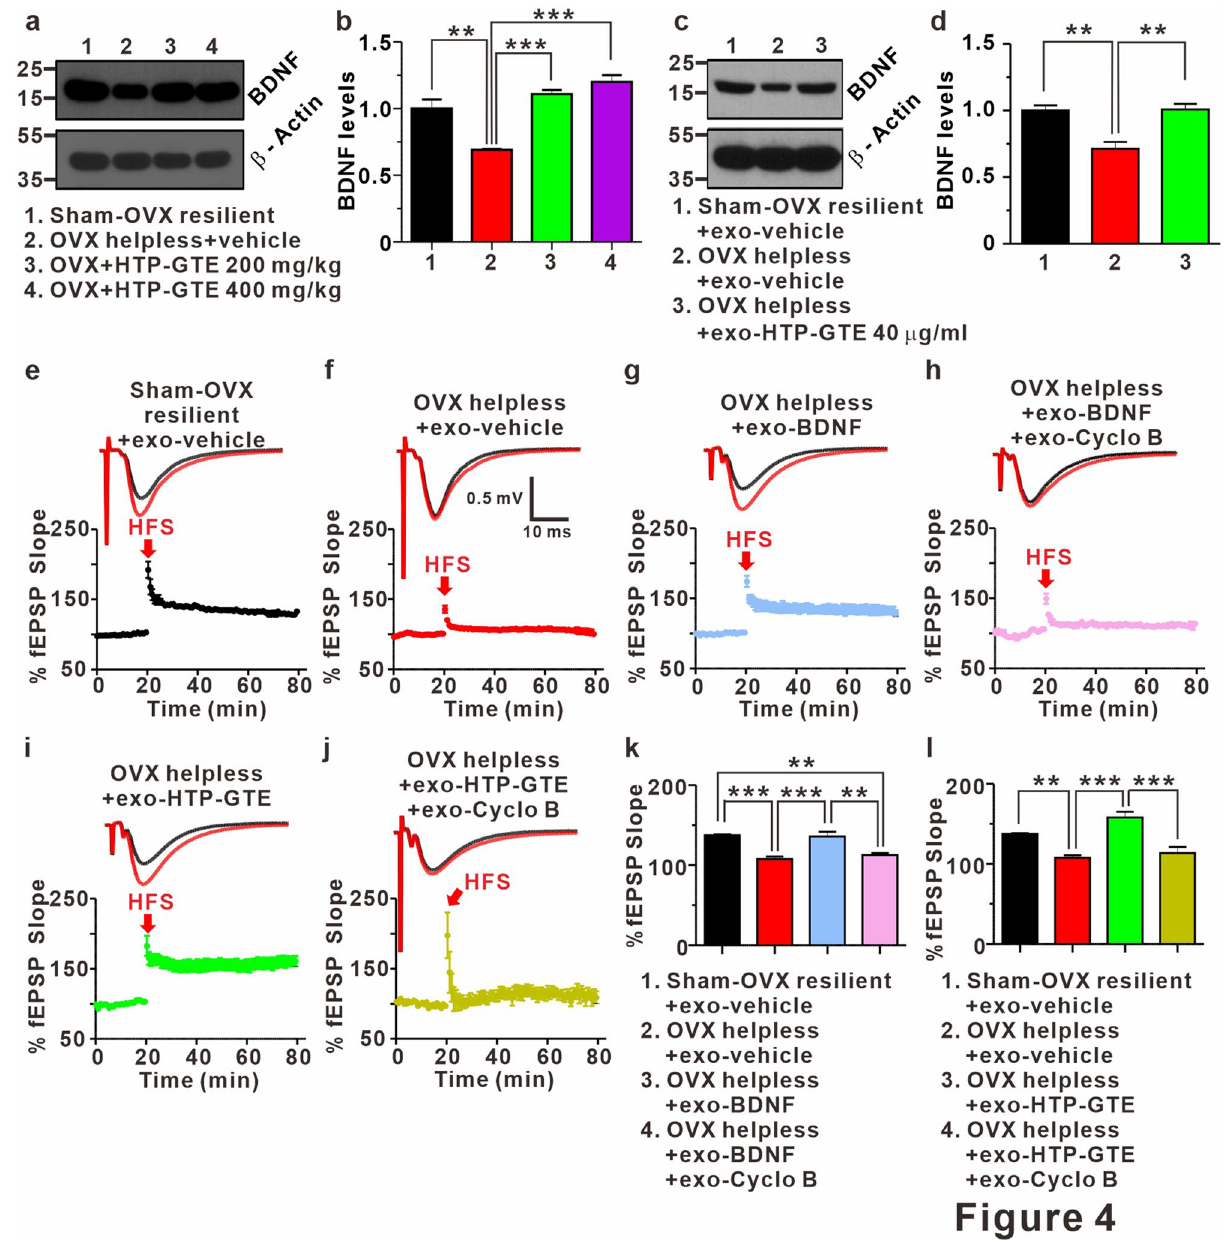
Figure 4. Regulation of BDNF-TrkB pathway underlies HTP-GTE-dependent amelioration of hippocampal synaptic impairments in helpless OVX rats. ( a, b ) Western blot of BDNF level in hippocampus on sham-OVX resilient + vehicle, OVX helpless + vehicle, OVX + HTP-GTE 200 mg/kg, and OVX + HTP-GTE 400 mg/kg groups in oral administration of HTP-GTE or vehicle solution daily for 4 weeks (Sham-OVX resilient + vehicle: 1.00 ± 0.07; OVX helpless + vehicle: 0.69 ± 0.01; OVX + HTP-GTE 200 mg/kg: 1.11 ± 0.03; OVX + HTP-GTE 400 mg/kg: 1.20 ± 0.05, n = 3 brains/group). Full-length blot is presented in Supplementary Fig. S13. ( c,d ) Western blot of BDNF level in hippocampus of exogenous application of HTP-GTE for 2 h (Sham-OVX resilient + exo-vehicle: 1.0 ± 0.04; OVX helpless + exo-vehicle: 0.71 ± 0.05; OVX helpless + exo-HTP-GTE 40 μg/ml: 1.01 ± 0.04, n = 3 brains/group). Full-length blot is presented in Supplementary Fig. S13. ( e–j ) Top: representative traces showing EPSPs before (average of 20 traces, black line) and after (average of 180 traces, red line) high-frequency stimulus. Bottom: average time courses for EPSP amplitudes during LTP induction in all groups. ( k,l ) Quantified graph was shown (Sham-OVX resilient + exo-vehicle: 137.4 ± 1.02, n = 5 slices/3 rats; OVX helpless + exo-vehicle: 107.6 ± 3.18, n = 8 slices/3 rats; OVX helpless + exo-BDNF (8 nM): 136.0 ± 5.74, n = 6 slices/3 rats; OVX helpless + exo-BDNF (8 nM) + exo-cyclo B: 112.8 ± 2.27, n = 6 slices/3 rats; OVX helpless + exo-HTP-GTE 40 μg/ml: 157.9 ± 7.21, n = 7; OVX helpless + exo-HTP-GTE 40 μg/ml + cyclo B: 113.4 ± 7.64, n = 6). Data are represented as mean ± SEM (One-way ANOVA Tukey’s post hoc test, **p < 0.01, ***p <